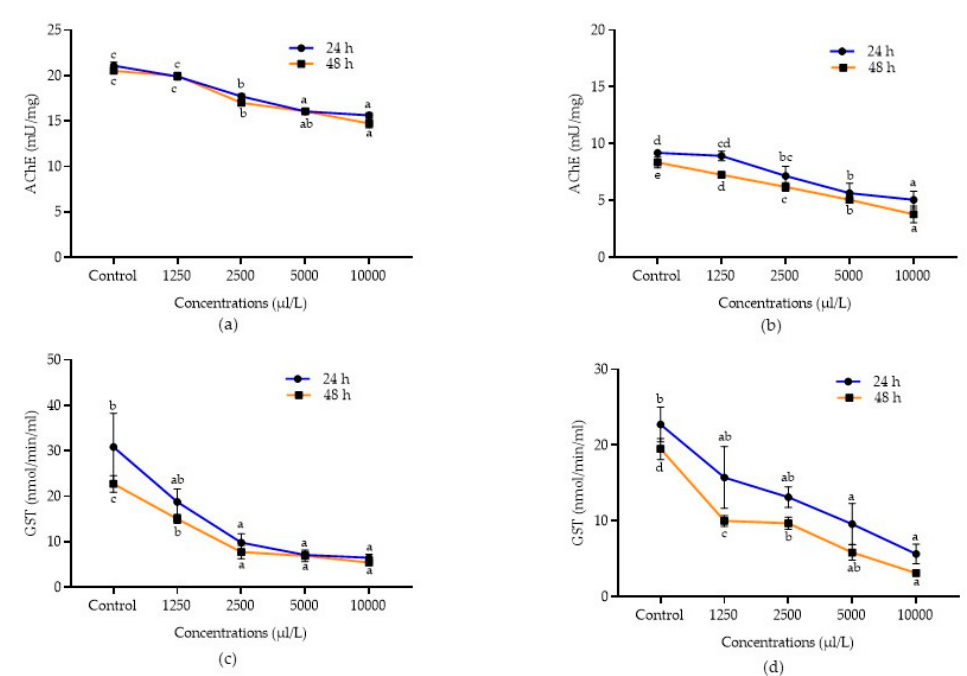
Figure 4. Detoxification enzyme inhibition activities of essential oils. AChE inhibition in C. chinensis treated with A. calamus ( a ) and L. angustifolia ( b ). GST inhibition in C. chinensis treated with A. calamus ( c ) and L. angustifolia ( d ). Mean ( ± SE) of three replications. Figures in the same letters do not differ significantly by Tukey’s HSD ( p ≥ 0.05).